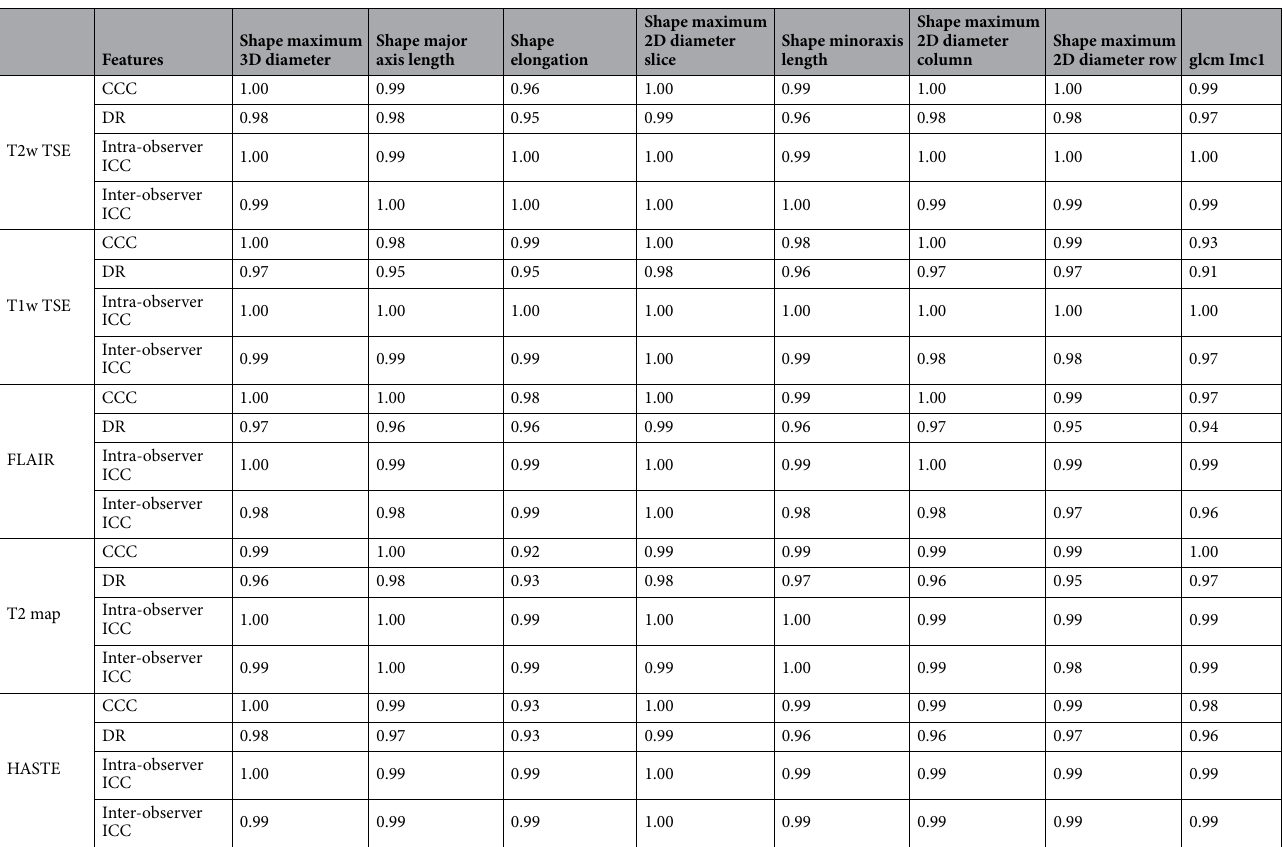
Table 2. Robust and reproducible features across all sequences. Across all sequences, eight features proofed to be robust and reproducible. Except of Imc1 from the GLCM feature class, all other features were shape